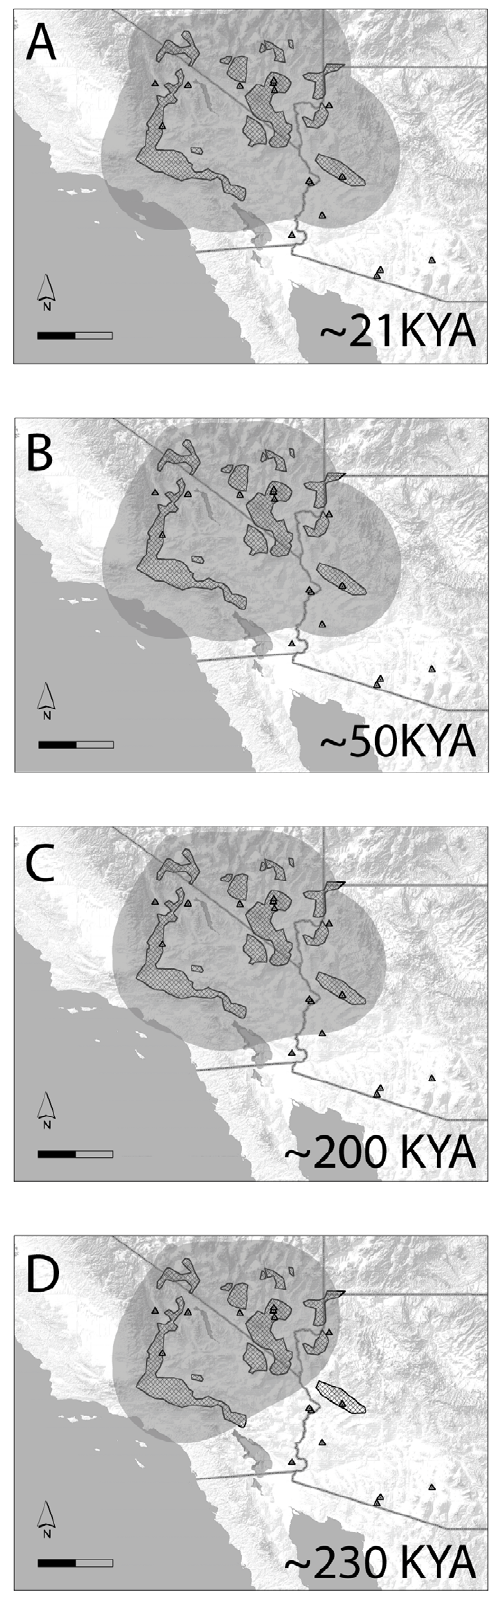
Figure 3. Spatial distribution of cpDNA haplotypes from Y. brevifolia through time. Distribution changes were inferred in a continuous phylogeographic analysis using a relaxed random walk with